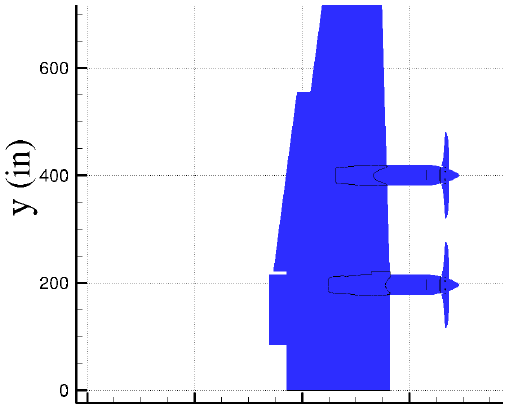
Figure 3. The location of flaps, nacelles, and propeller on the wing.